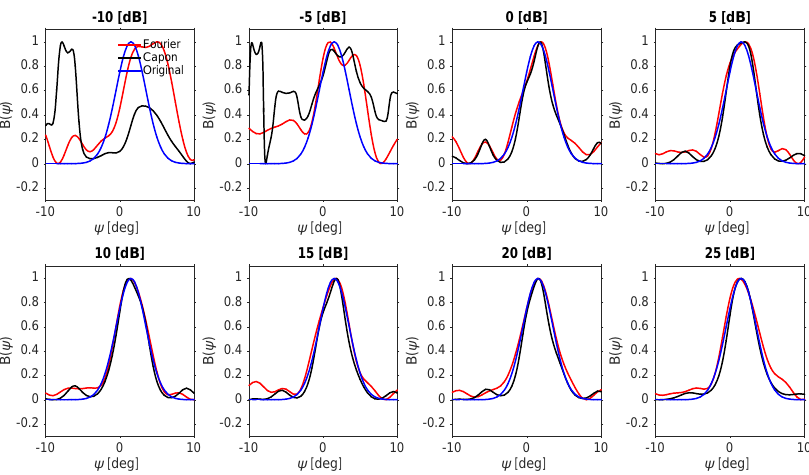
Figure 2. Numerical simulations of the Fourier and Capon methods under different SNR conditions. The simulated brightness function is described by a Gaussian function centered at 1.5 ◦ with an angular width of 2 ◦